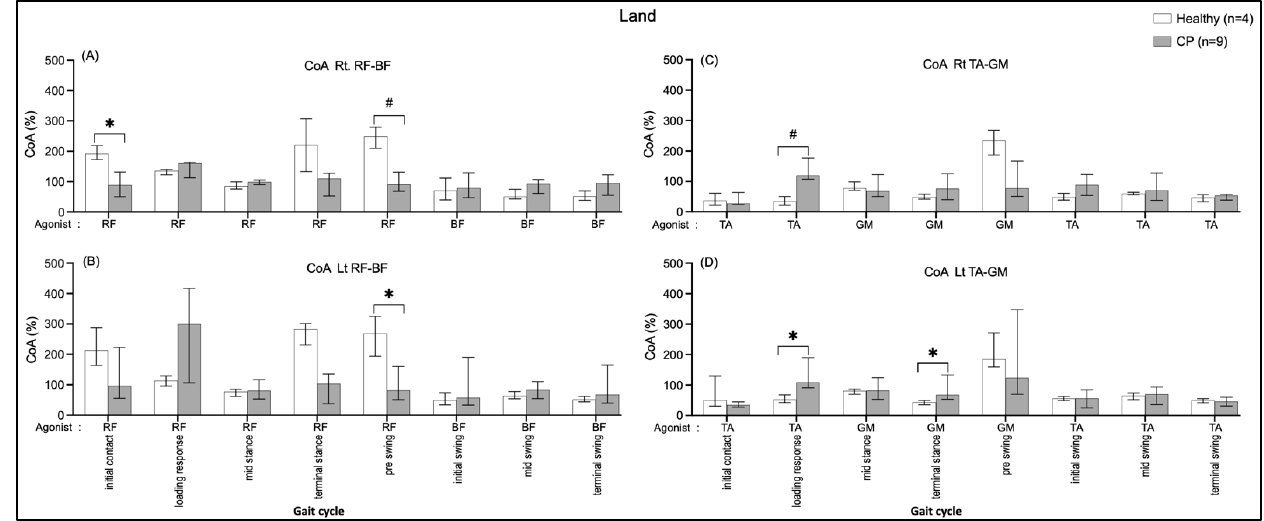
Figure 8. Co-activation index (CoA) of right RF-BF ( A ), left RF-BF ( B ), right TA-GM ( C ), and left TA-